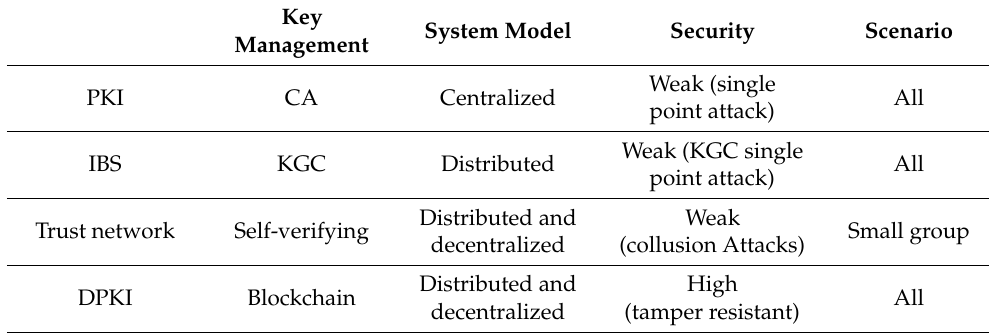
Table 1. The limitations of the existing literature. Key System Model Security Management